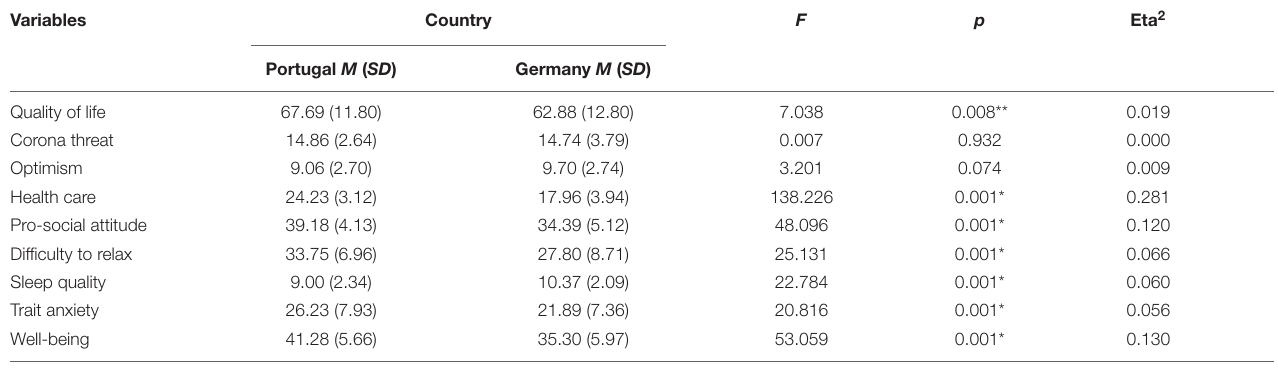
TABLE 3 | Differences in groups by country.